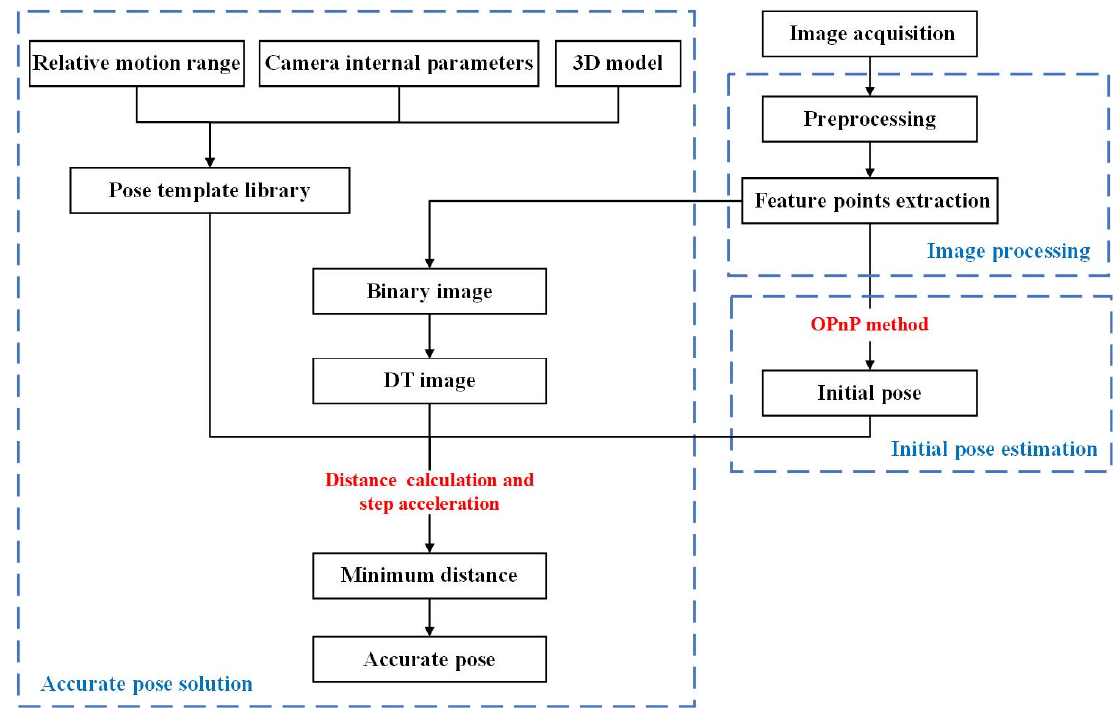
Figure 1. Flow diagram of the pose estimation method.